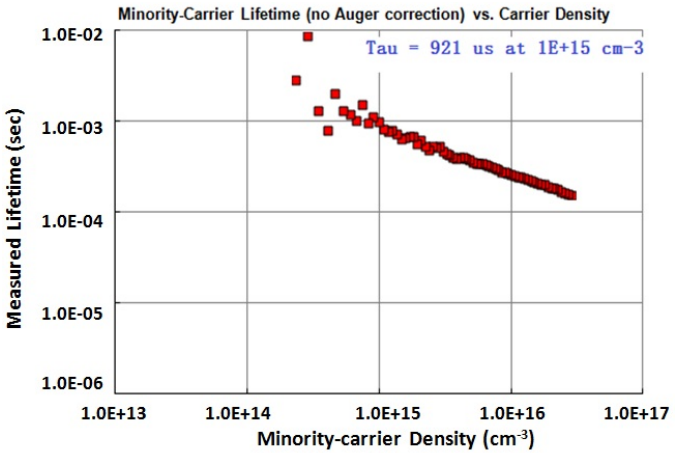
Figure 5. Minority carrier lifetime as function of carrier density for 8-nm-thick TiO 2 film deposited at substrate temperature 200 °C.